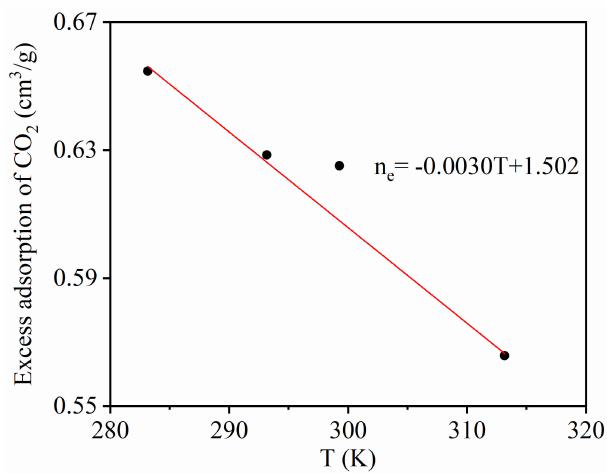
Figure 5. Temperature dependence of CO 2 maximum excess